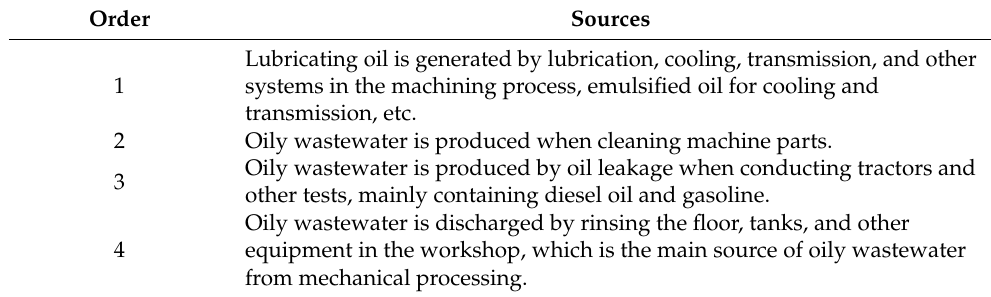
Table 6. Sources of metal processing